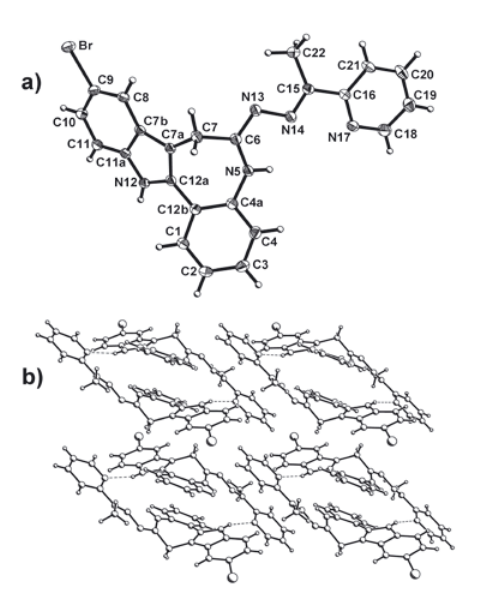
Figure 2. a) ORTEP plot of molecule of 4 with atom labeling scheme; thermal ellipsoids are drawn at 50% probability level. Selected bond lengths (Å): C4a-N5 1.4065(16), C6-N5 1.3621(16), C6-N13 1.3088(16), N13-N14 1.4044(15), N14-C15 1.2898(16); b) Packing of 4 with hydrogen bonds; view approximately along [0 1